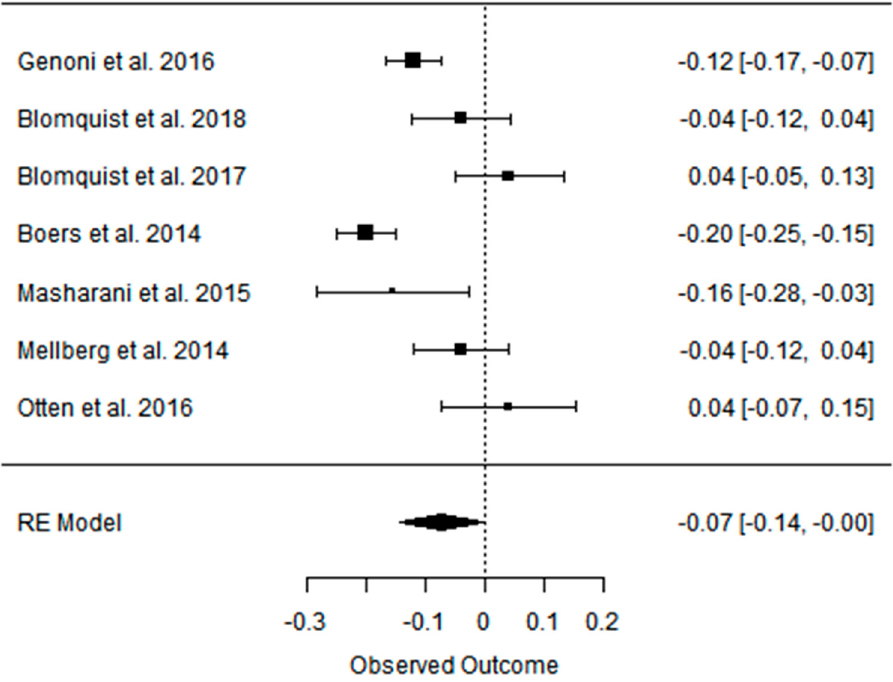
Figure A22. Forest plot of the effect of a CD on HDL-C in the short term (weighted mean difference).